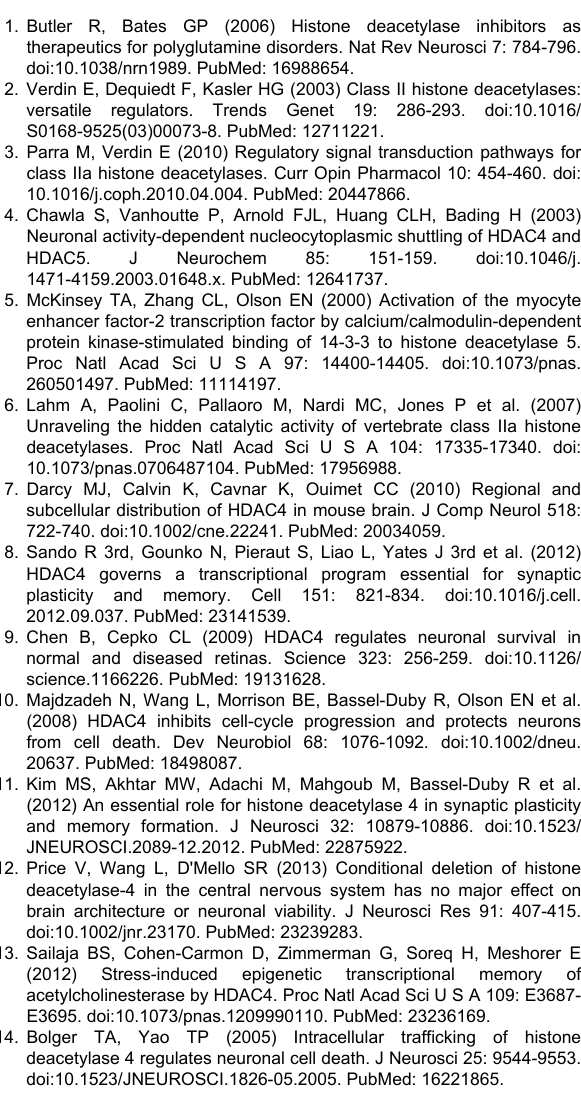
Table S1. Summary data table of all acetylated peptides identified in the AcetylScan study. The Details tab is a redundant list of all identifications with accompanying scoring metrics and links to labelled MS/MS spectra. The Summary